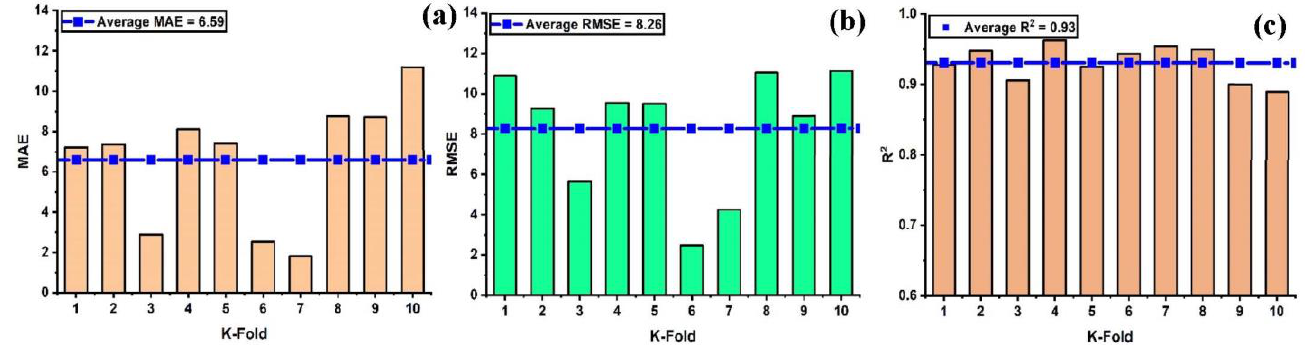
Figure 8. Cross validation; ( a ) SVR with MAE; ( b ) SVR with RMSE; ( c ) SVR with R 2 .